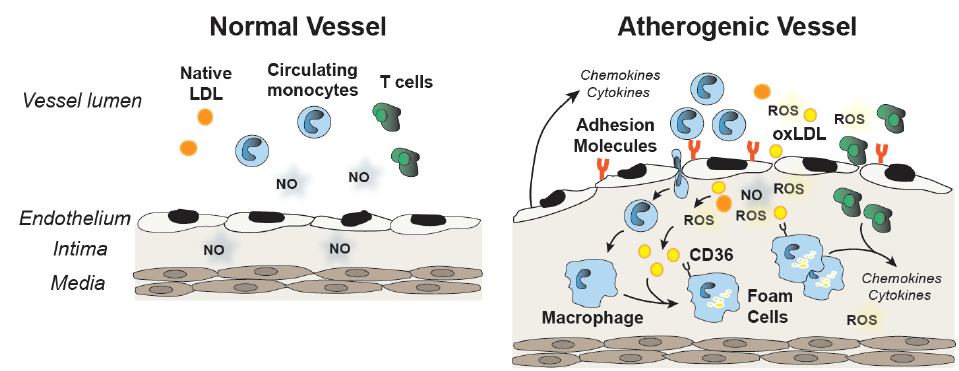
Figure 2. Plaque development in blood vessels. The normal vessel has an endothelial cell layer that produces nitric oxide (NO). Endothelial cell dysfunction and an accumulation of reactive oxygen species (ROS) promotes the pro-inflammatory activation of endothelial cells, including the release of chemokines and cytokines and the expression of adhesion molecules that contribute to the uptake of monocytes and T cells in the intima. Conversion of monocytes to macrophages and foam cells that take up oxidized LDL (oxLDL) through CD36 receptors as well as the activation of T cells causes the release of additional proatherogenic chemokines and cytokines and plaque development.